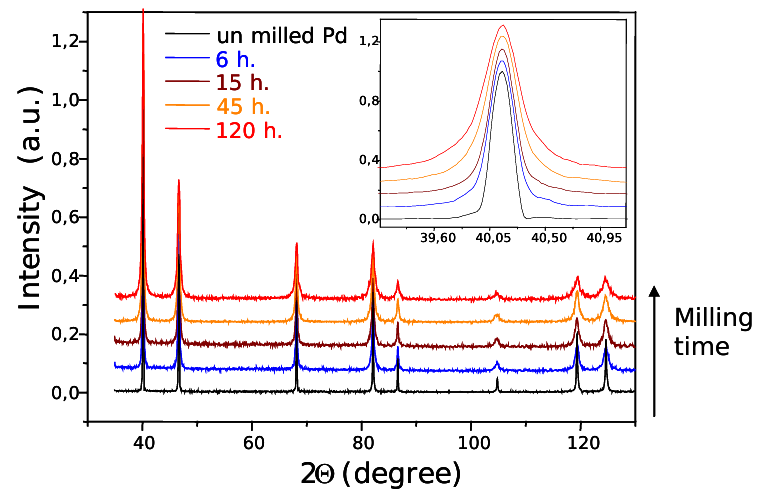
FIGURE 7. XRD pattern from Pd powder milled at different times showing the decrease of particle size.